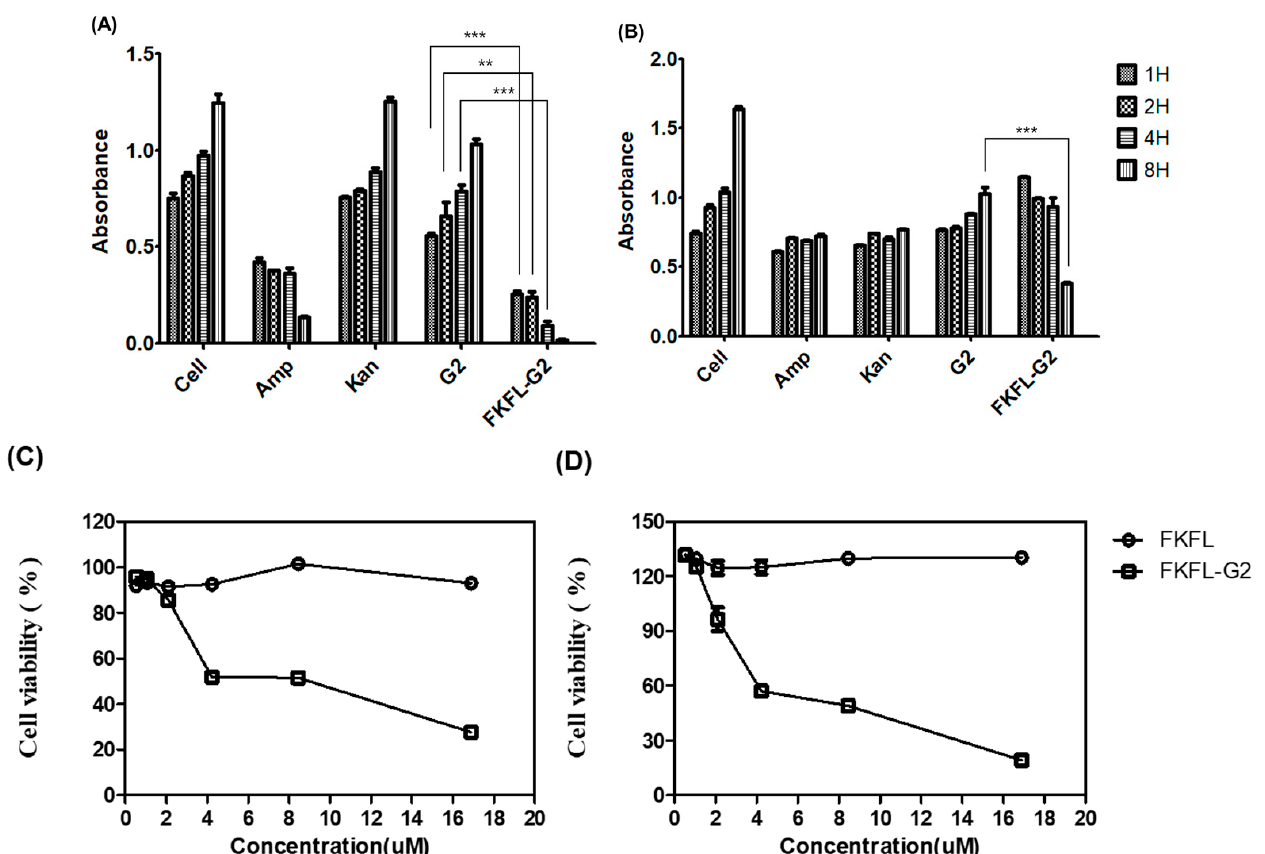
Figure 4. Antibacterial effect of FKFL-G2, second-generation polyamidoamine (G2 PAMAM), kanamycin (Kan), and ampicillin (Amp) on ( A ) E. coli and ( B ) S. aureus . The relationship between the FKFL peptide and FKFL-G2 concentration and bacterial cell viability was evaluated in ( C ) E. coli and ( D ) S. aureus . The results are shown as the mean ± SD ( n = 3). Statistical analysis of the experimental data was performed by the Student’s t -test using the GraphPad Prism 5 program (**, p < 0.01 and ***, p < 0.001).